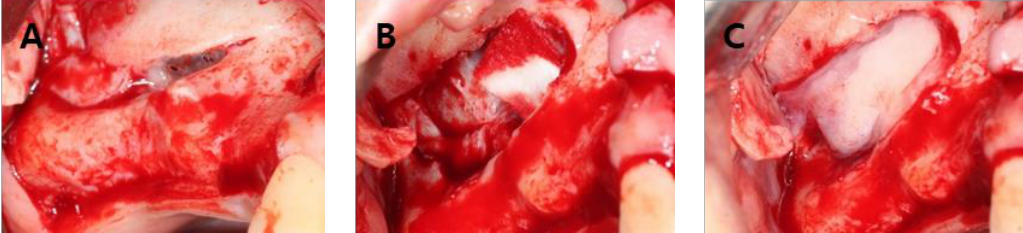
Figure 1. Small perforation of sinus membrane during sinus floor elevation procedure. ( A ) Small perforation during surgical window. ( B ) Repair with collagen membrane (CM). ( C ) Bone graft and repositioning of bony window.